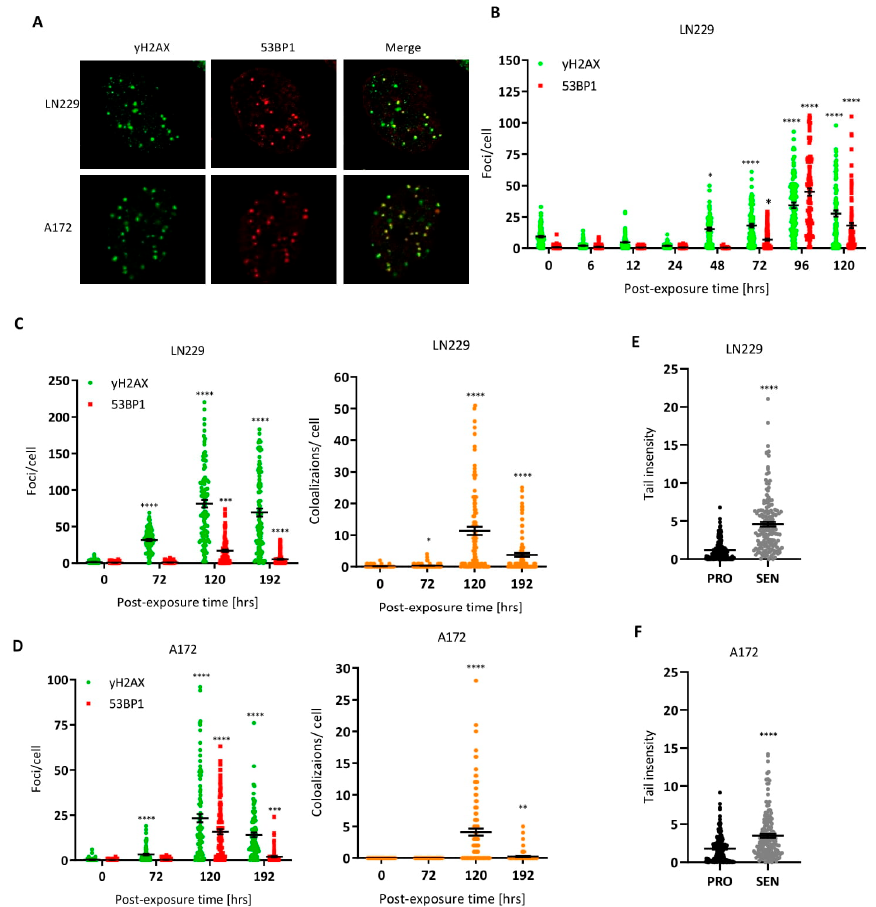
Figure 2. DNA double-strand breaks precede apoptosis and CSEN and persist in senescent cells. ( A ) Exemplary picture of γ H2AX and 53BP1 foci staining in LN229 and A172 cells following treatment with 50 µM TMZ for 5 days. ( B ) Kinetics of DSBs measured by γ H2AX and 53BP1 staining in LN229 cells following 20 µM TMZ treatment. ( C – F ) Sustained DSBs in LN229 ( C , D ) and A172 ( E , F ) cells following 50 µM TMZ treatment, shown by γ H2AX and 53BP1 staining. Nuclear foci and colocalization of foci were determined ( C , D ). ( E , F ) DSBs as measured by the neutral comet assay in proliferating (control) and senescent cells (CSEN). * p < 0.05, ** p < 0.01, *** p < 0.001; **** p < 0.0001.